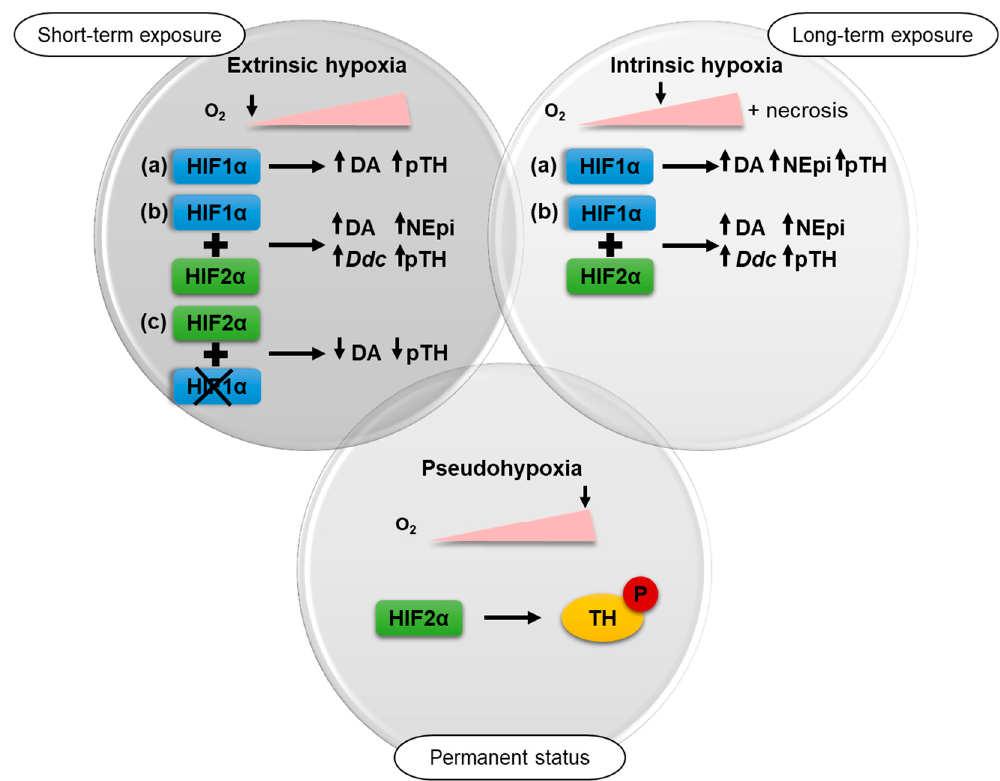
Figure 7. In the present study, the impact of three different types of hypoxia on the